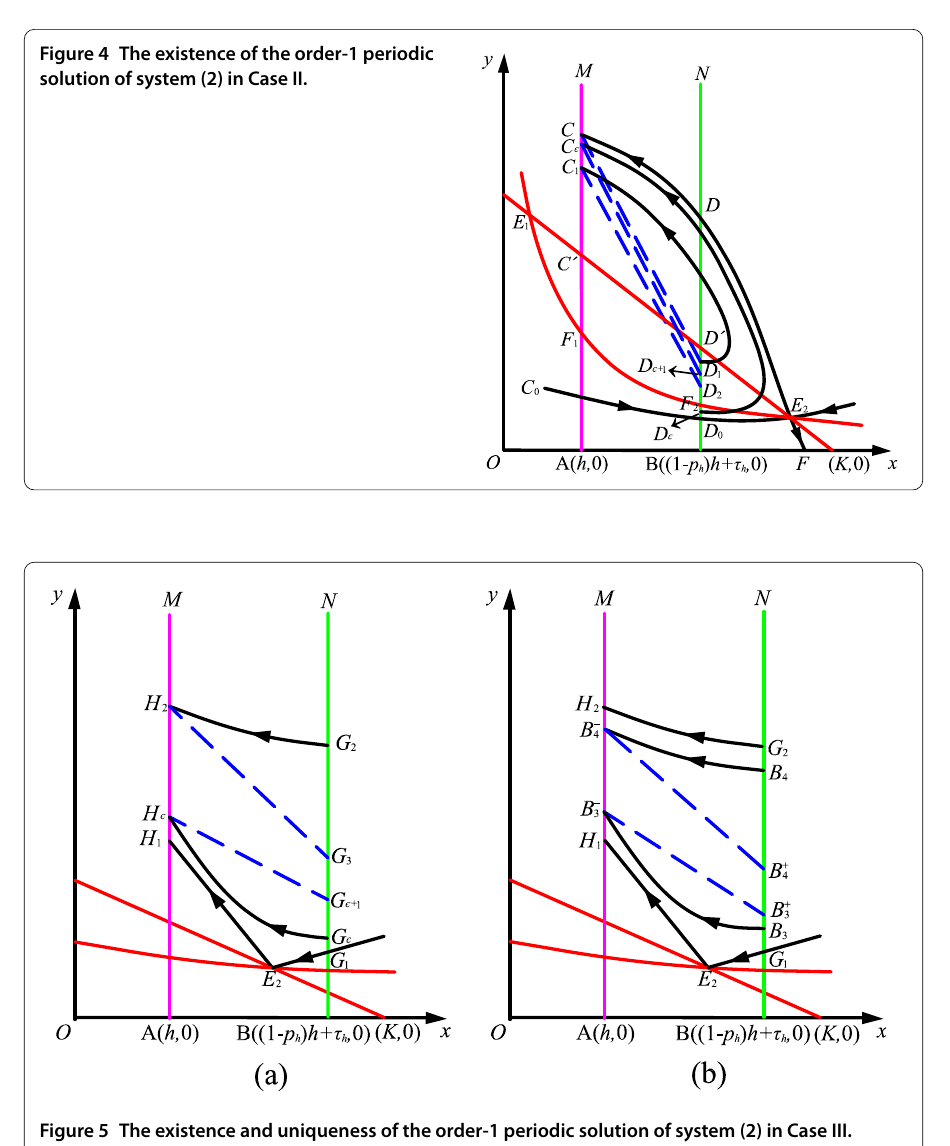
Figure 5 The existence and uniqueness of the order-1 periodic solution of system (2) in Case III. (a) The existence of the periodic solution. (b) The uniqueness of the periodic